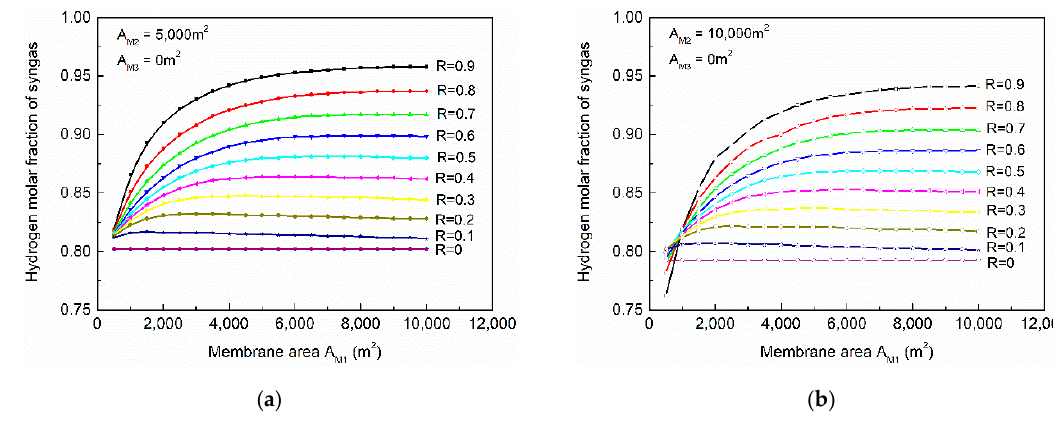
Figure 8. Impacts of syngas cut ratio and membrane area on syngas hydrogen purity. ( a ) Area of membrane-202 was 5000 m 2 ; ( b ) area of membrane-202 was 10,000 m 2 .